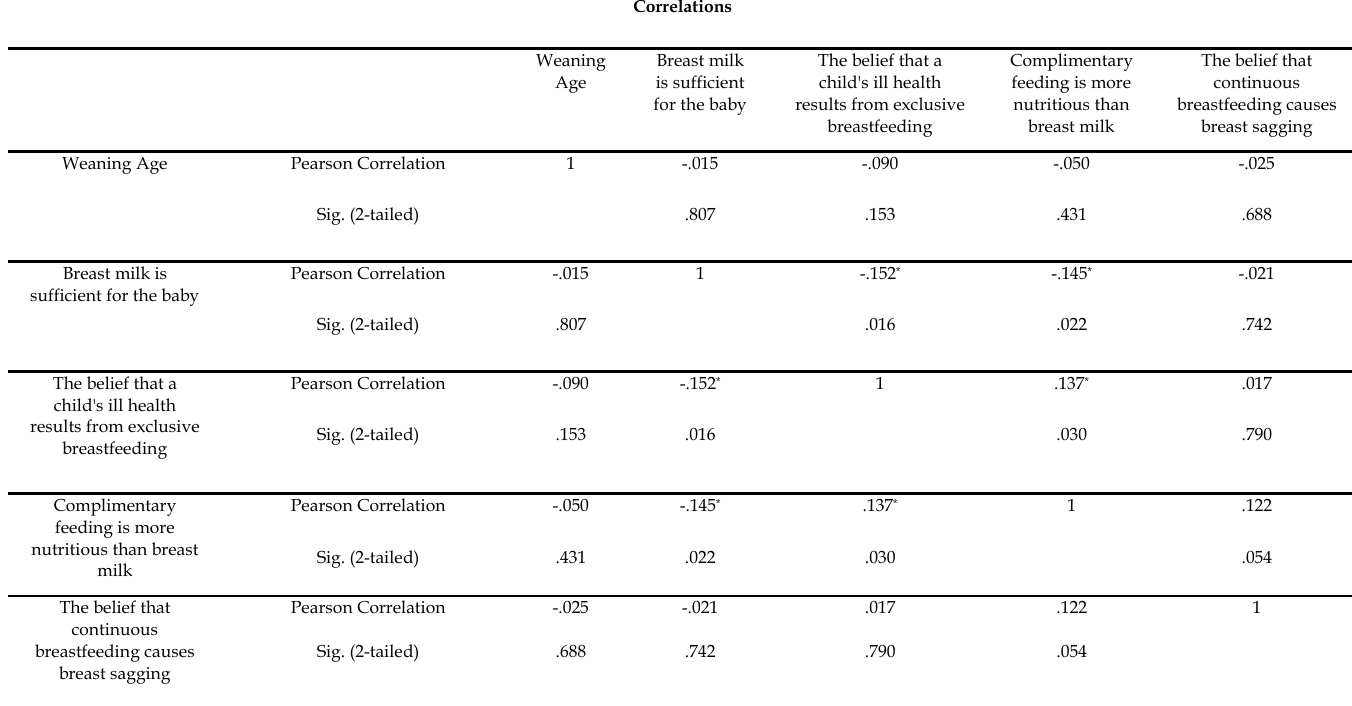
Table 4: Correlation between cultural belief and early child weaning among mothers (N =